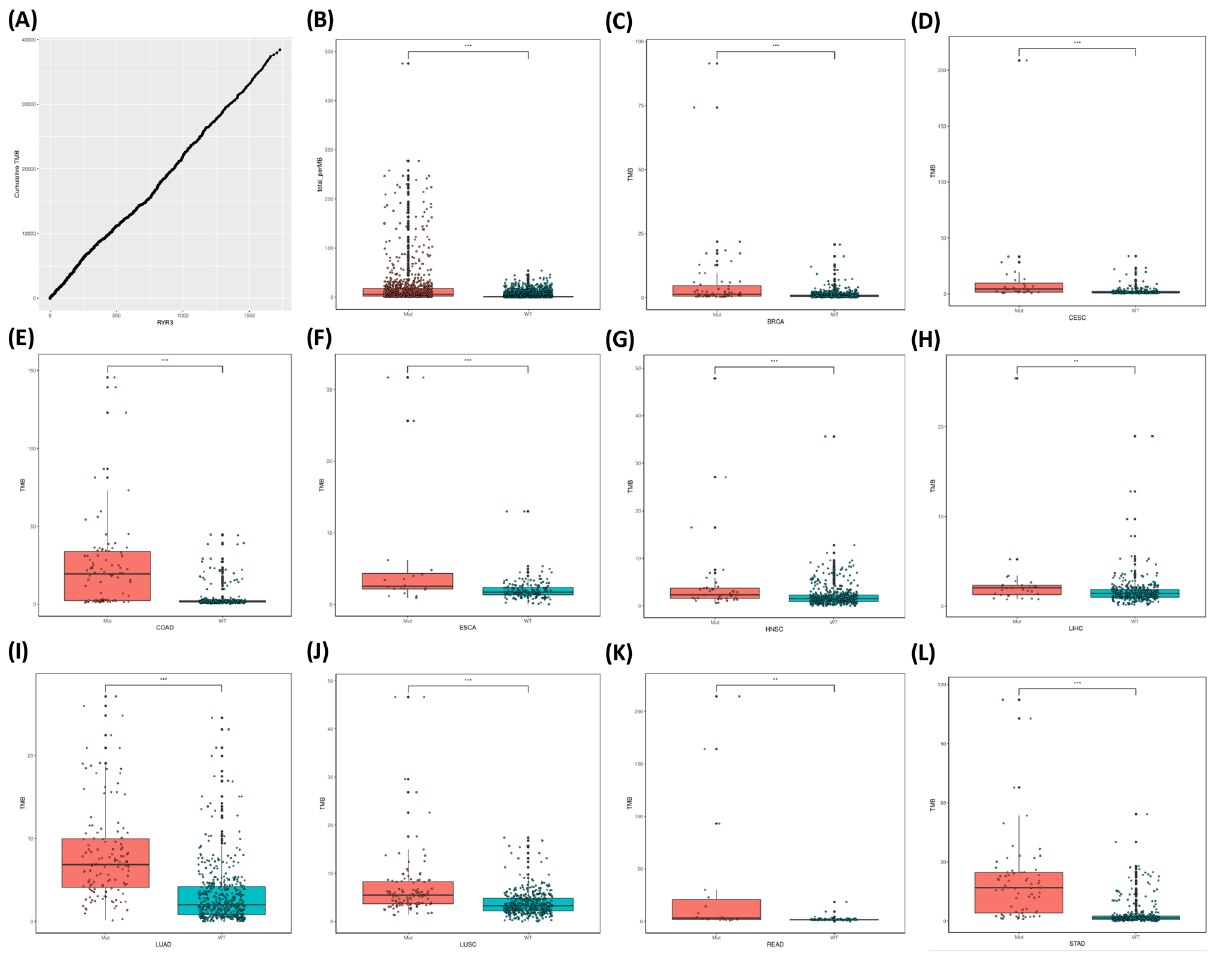
Figure 5. The correlation between RYR3 mutational status and tumor mutational burden (TMB). ( A ) The correlation between cumulative number of mutations (X-axis) and cumulative TMB (Y-axis) in RYR3. ( B ) Scatter plot of TMB grouped by RYR3 mutational status (mutant or WT) in all types of cancers. ( C – L ) Scatter plot of TMB grouped by RYR3 mutational status (mutant or WT) in each type of cancer, as indicated. *P < 0.05; **P < 0.01; ***P <